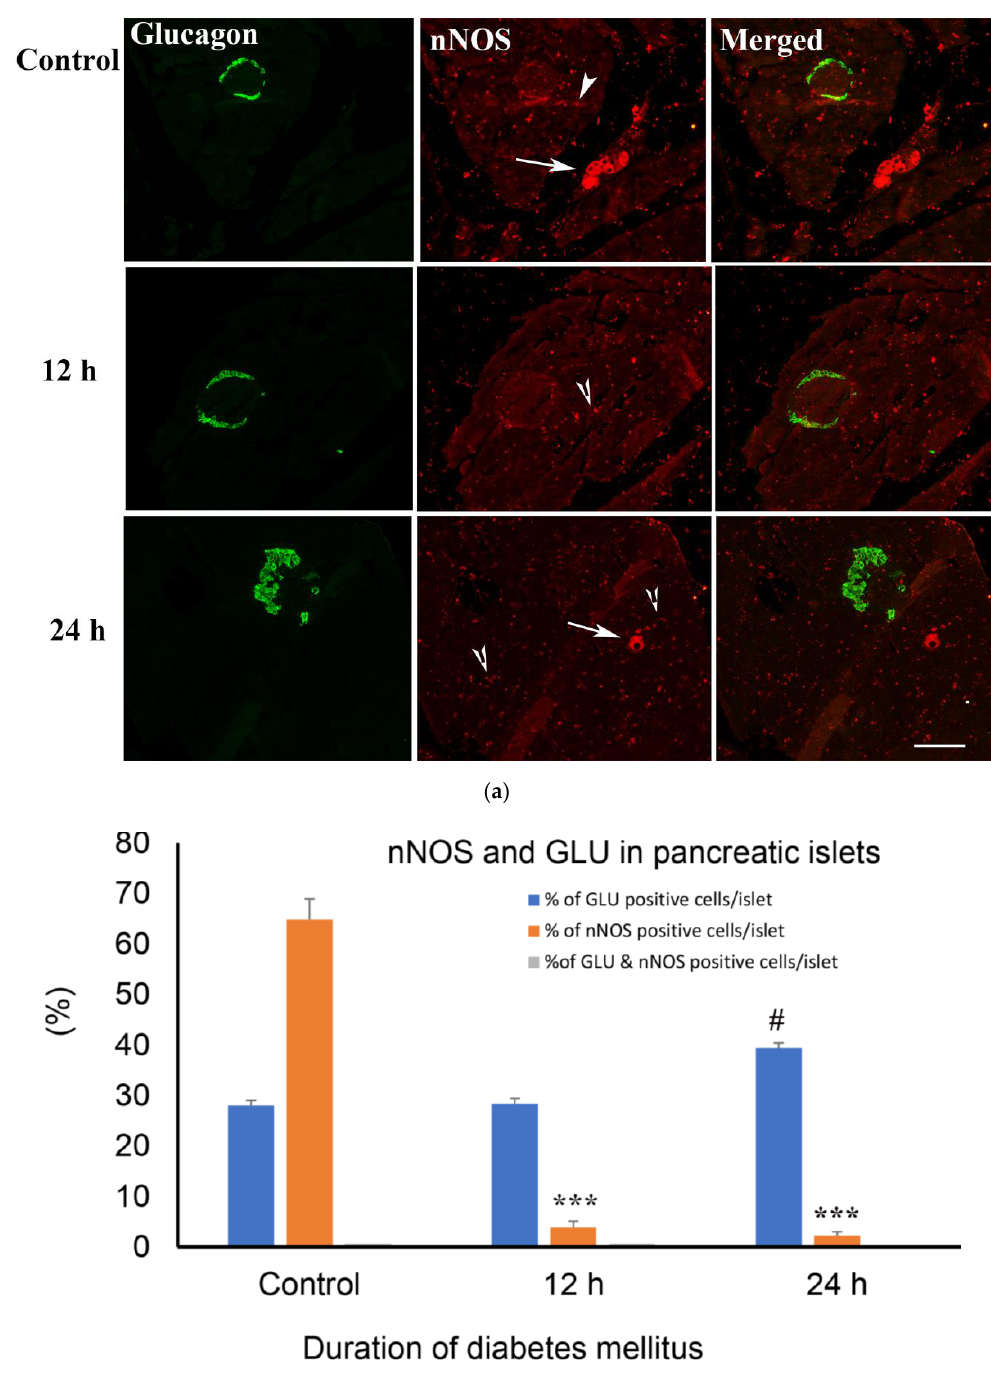
Figure 6. ( a ) shows glucagon (GLU)-(green) and nNOS-(red)-immuno-positive cells in the islet of Langerhans of rats of control and those with 12 h and 24 h of diabetes. There was no co-localization between glucagon and nNOS. nNOS-immunoreactive ganglion cell (arrow) and varicose nerve fibres (arrow head) were observed in the exocrine pancreas. Note the significant increase in the number of nNOS-containing nerve profiles after 12 and 24 h of diabetes. Scale bar = 10 µ m. ( b ) shows morphometric analysis of glucagon-positive cells in the islet cells of the endocrine pancreas. There was a significant (*** p < 0.001) reduction in the number of nNOS-immunoreative cells in the islet of Langerhans compared to control. The number of glucagon-positive cells in the islets increased markedly (# p < 0.01) 24 h after the induction of diabetes, compared to the control (n =